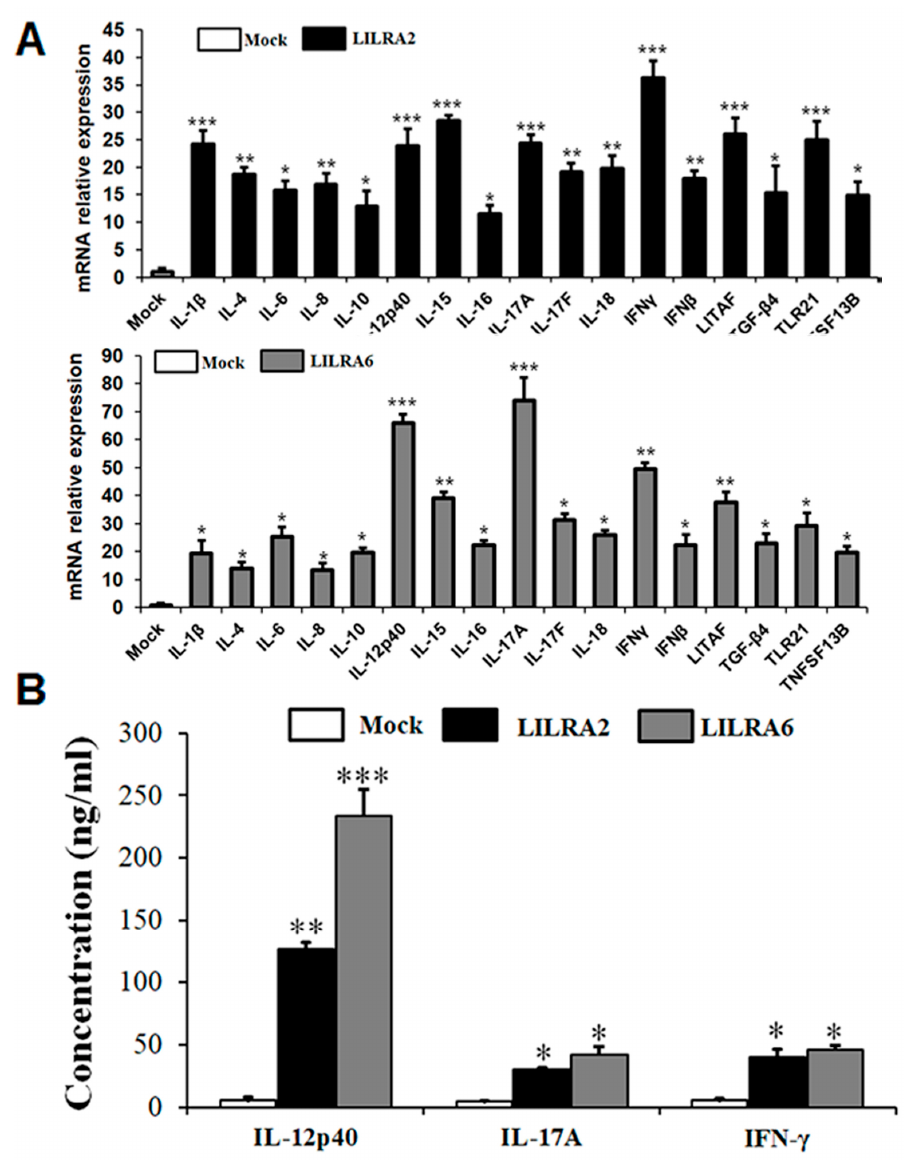
Figure 7. Chicken LILRA2 and LILRA6 activate cytokine production. Cytokine mRNA ( A ) and protein ( B ) expression levels in LILRA2 and LILRA6 transfected HD11 cells. Data are presented as the mean ± SEM of three independent experiments: * p < 0.05, ** p < 0.01 and *** p < 0.001.